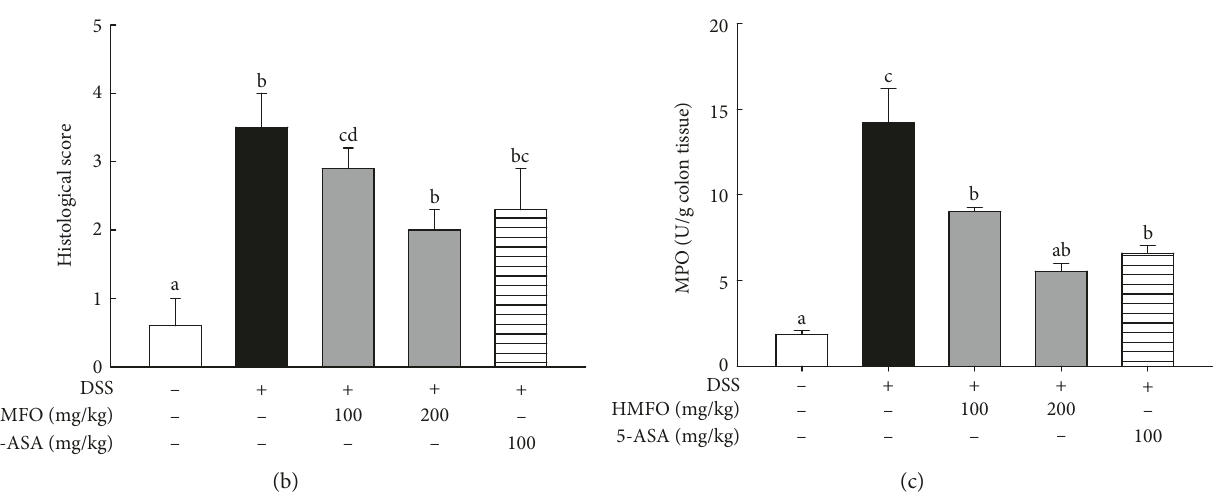
Figure 2: E ff ects of HMFO on colonic histology and MPO levels in mice with DSS-induced colitis. (a) Histological changes of colonic tissue were determined by hematoxylin and eosin (H&E) staining and observation by light microscopy ( × 20 and × 40). Left panel: low-power view (scale bar =100 μ m). Right panel: high-power view (scale bar =50 μ m). (b) Histological scores were assigned according to the criteria de fi ned in Section 2.5. (c) MPO was extracted from colon tissue specimens and assayed for colorimetric activity, with the activity determined as the units per gram of colonic tissue. Values with di ff erent letters are signi fi cantly di ff erent ( p < 0 05 ). 5-ASA, 5-aminosalicylic acid (100mg/kg); DSS, dextran sulfate sodium; HMFO, polysaccharides of Cynanchum wilfordii (100 or 200mg/kg); MPO,